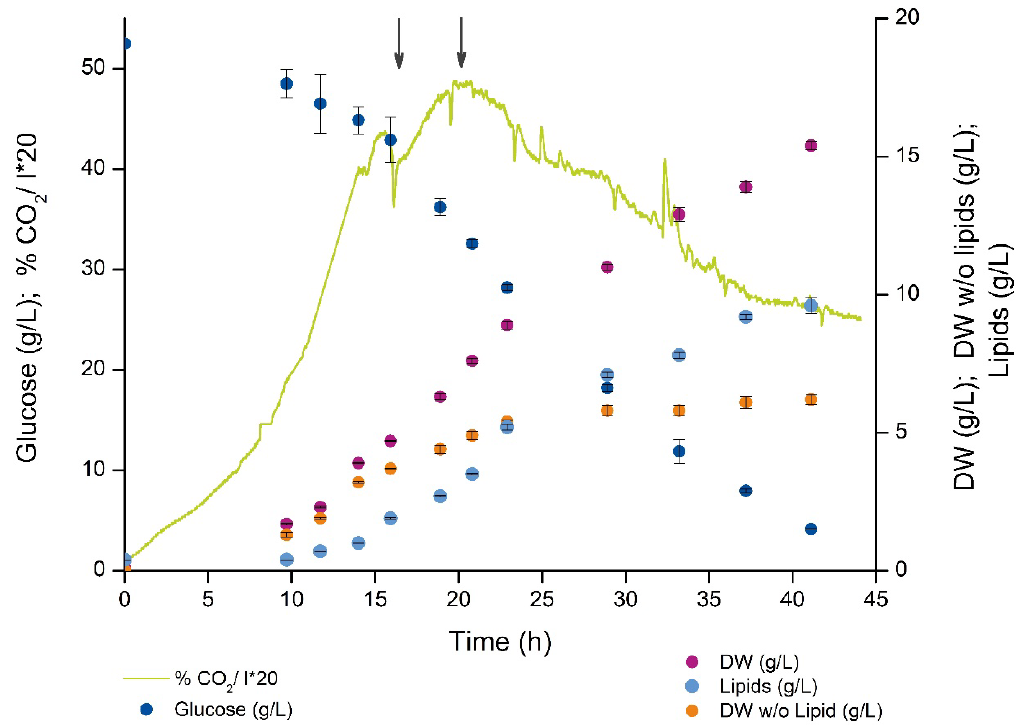
Figure 2. Time-course profile for the nitrogen limited Aurantiochytrium sp. T66 bioreactor cultivation showing the continuous CO 2 exhaust gas production (left y -axis, percentage in off-gas*20), glucose consumption (left y -axis, in g/L) and biomass formation (with and without intracellular lipids), and total lipid (TL) formation (biomass and lipid concentration in grams/L on the right y -axis). The two arrows indicate metabolic events discussed in the text. One representative biological replica is shown, error bars indicate standard deviation of at least three resamplings.